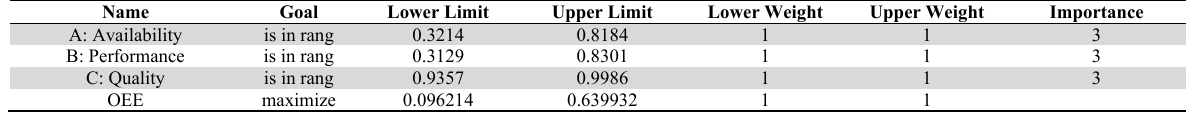
Criteria for optimal solutions in the system constraints